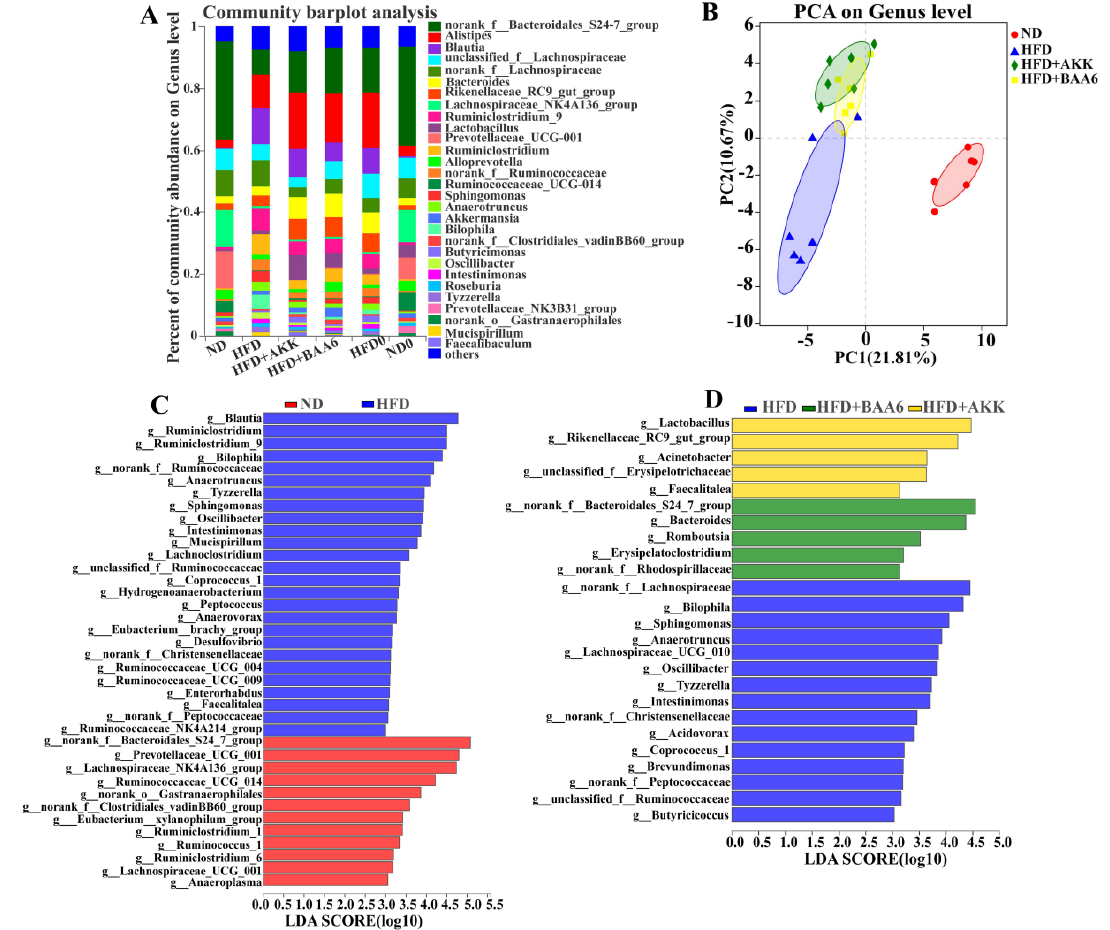
Figure 3. Effects of BAA6 or AKK on gut microbiota in HFD-fed mice. ( A ) Relative abundance of the gut microbial community at the genus level. ( B ) Principal component analysis (PCA) score plots at the genus level. ( C ) Histogram of the linear discriminant analysis (LDA) scores between the ND and HFD groups, and ( D ) histogram of LDA scores among the HFD, HFD + AKK, and HFD + BAA6 groups. The differences with an LDA score greater than three are considered significant. n = 6